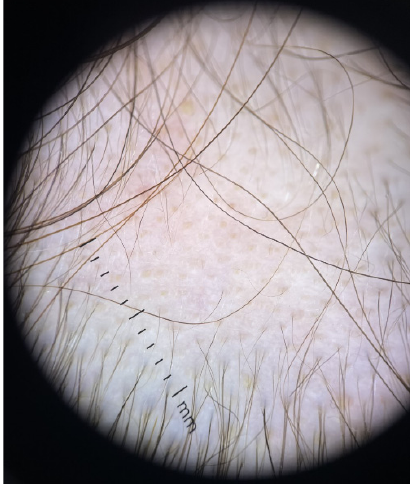
Figure 2. Trichoscopy aspect of alopecia areata; this is a 25-year-old female patient confirmed with Hashimoto’s thyroiditis and normal thyroid function (TSH of 2.27 µUI/mL, normal between 0.5 Hashimoto’s thyroiditis and normal thyroid function (TSH of 2.27 µ UI/mL, normal between 0.5 and and 4.5 µUI/mL, high TPO-Ab of 109 UI/mL, normal <35 UI/mL). 4.5 µ UI/mL, high TPO-Ab of 109 UI/mL, normal < 35